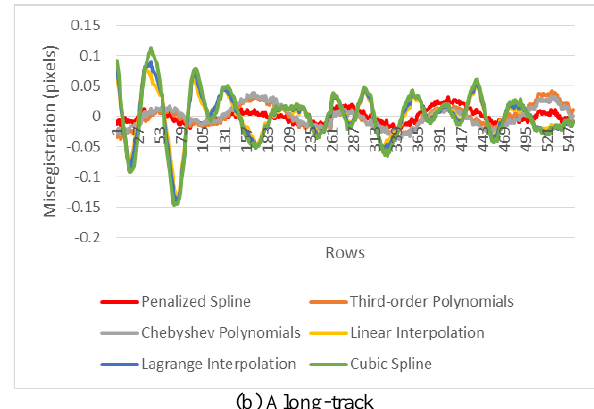
Figure 7 Band-to-band misregistration of Faizabad dataset caused by the attitude errors.